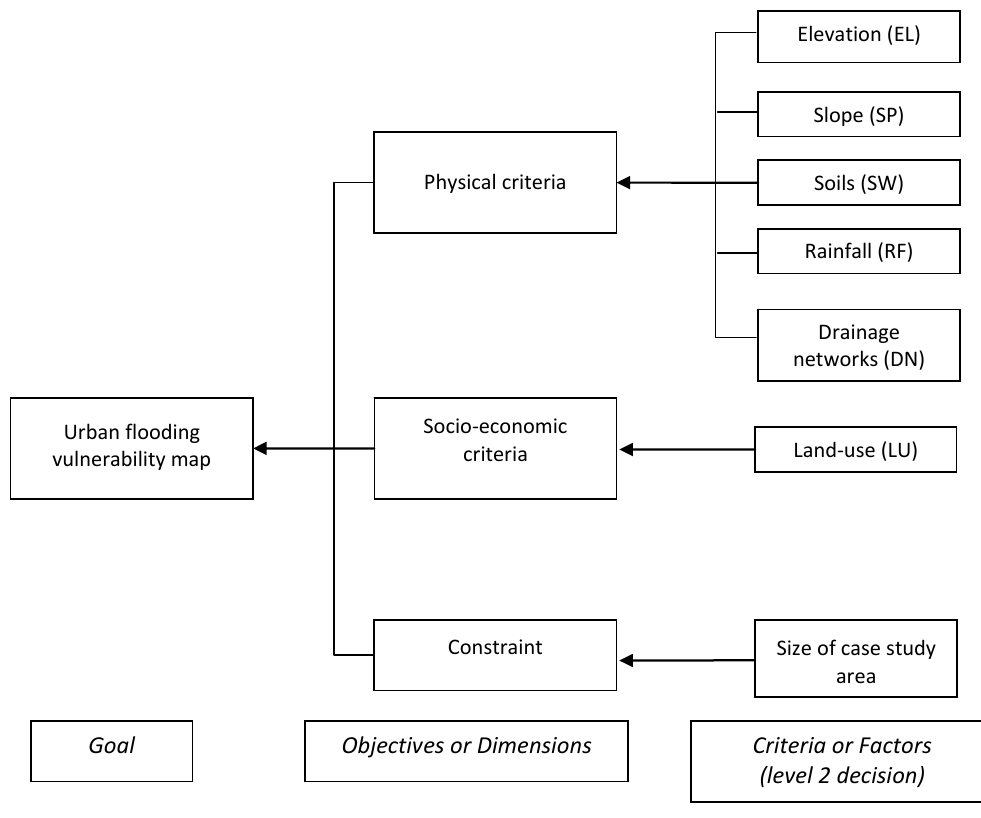
Figure 6. A three-level hierarchical structure of the characteristics of the parameters that represents urban flood